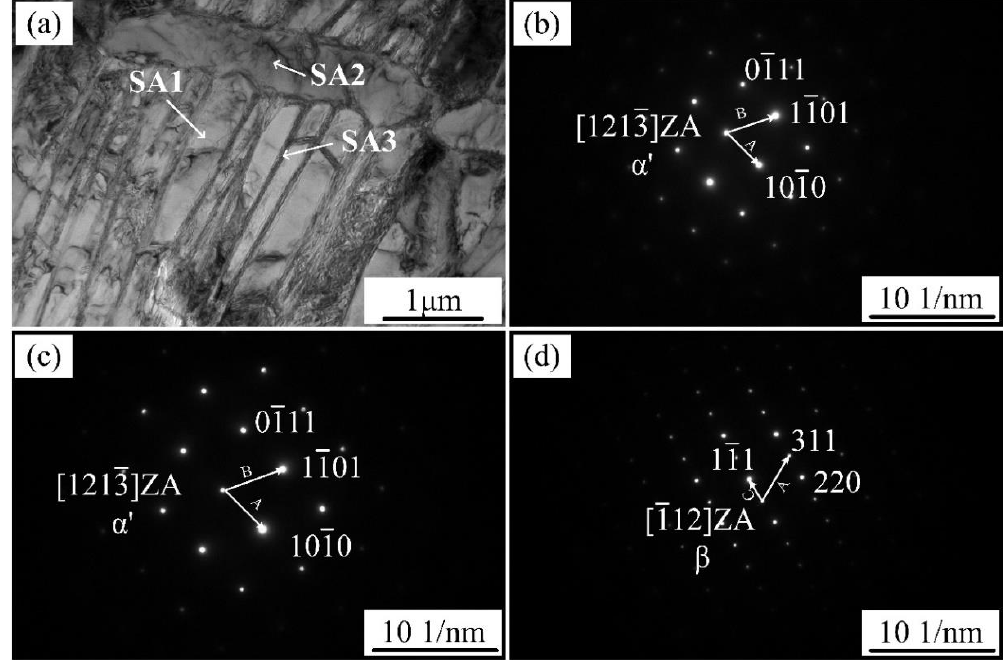
Figure 6. ( a ) TEM bright-field image of the weld seam; ( b ) selected area electron diffraction (SAED) patterns of SA1; ( c ) SAED patterns of SA2; and ( d ) SAED patterns of